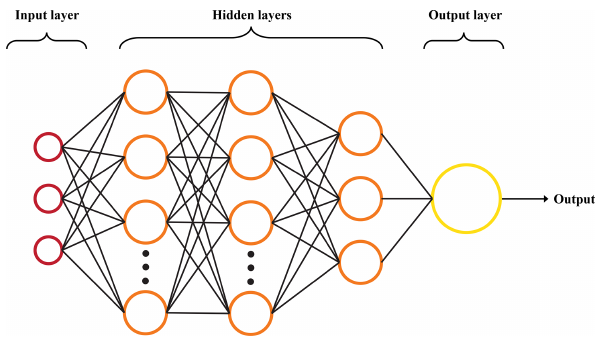
Figure 1. Artificial neural network diagram. Input nodes are in red, hidden nodes in orange, and the output node in yellow. Black lines represent weighted connections between